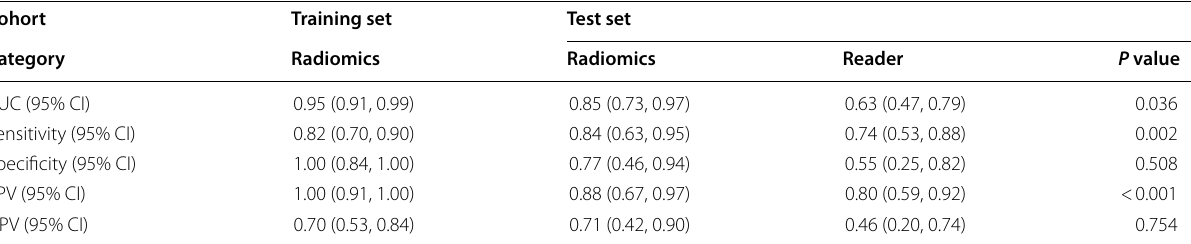
Table 2 Diagnostic performances of the radiomics model and visual assessment by nuclear medicine radiologists